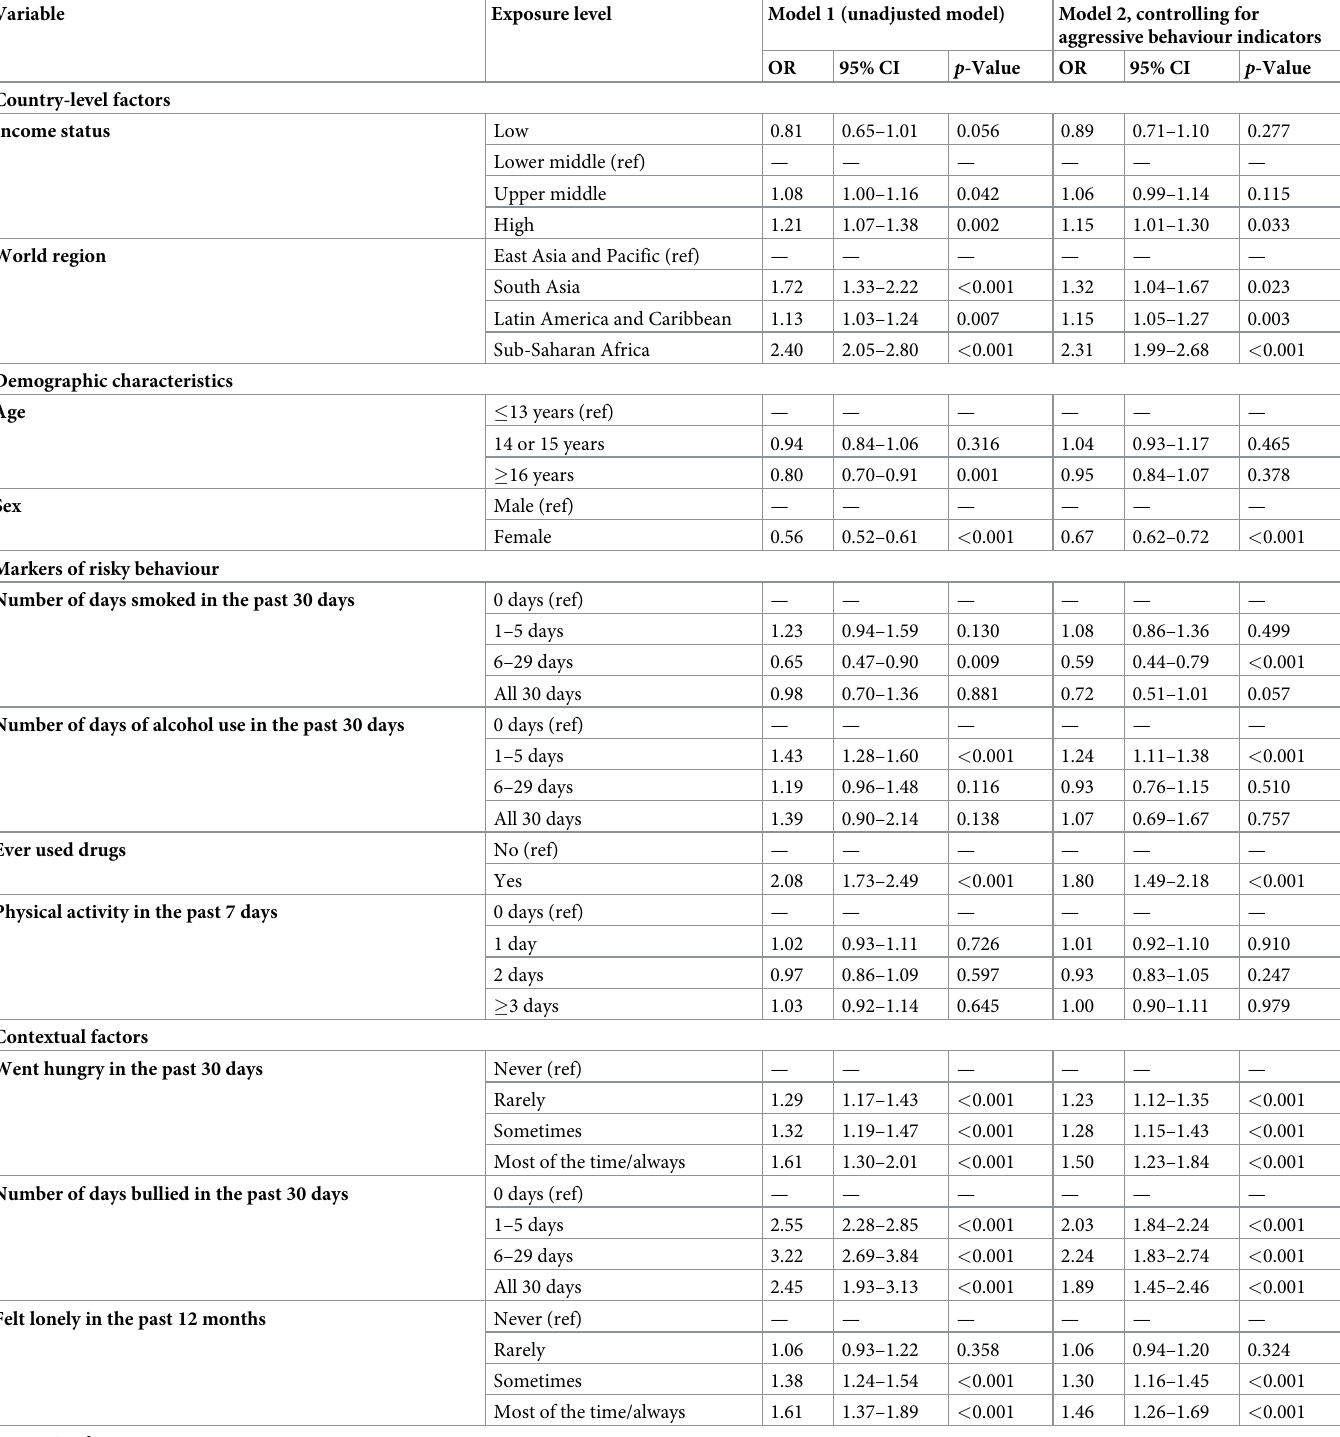
Table 3. Multivariable associations between serious injury occurrence, country-level factors, and individual-level factors of risky behaviour, contextual factors, pro- tective factors, and indicators of poor mental health (model 1; model 2 shows the results when aggressive behaviour indicators are added to the